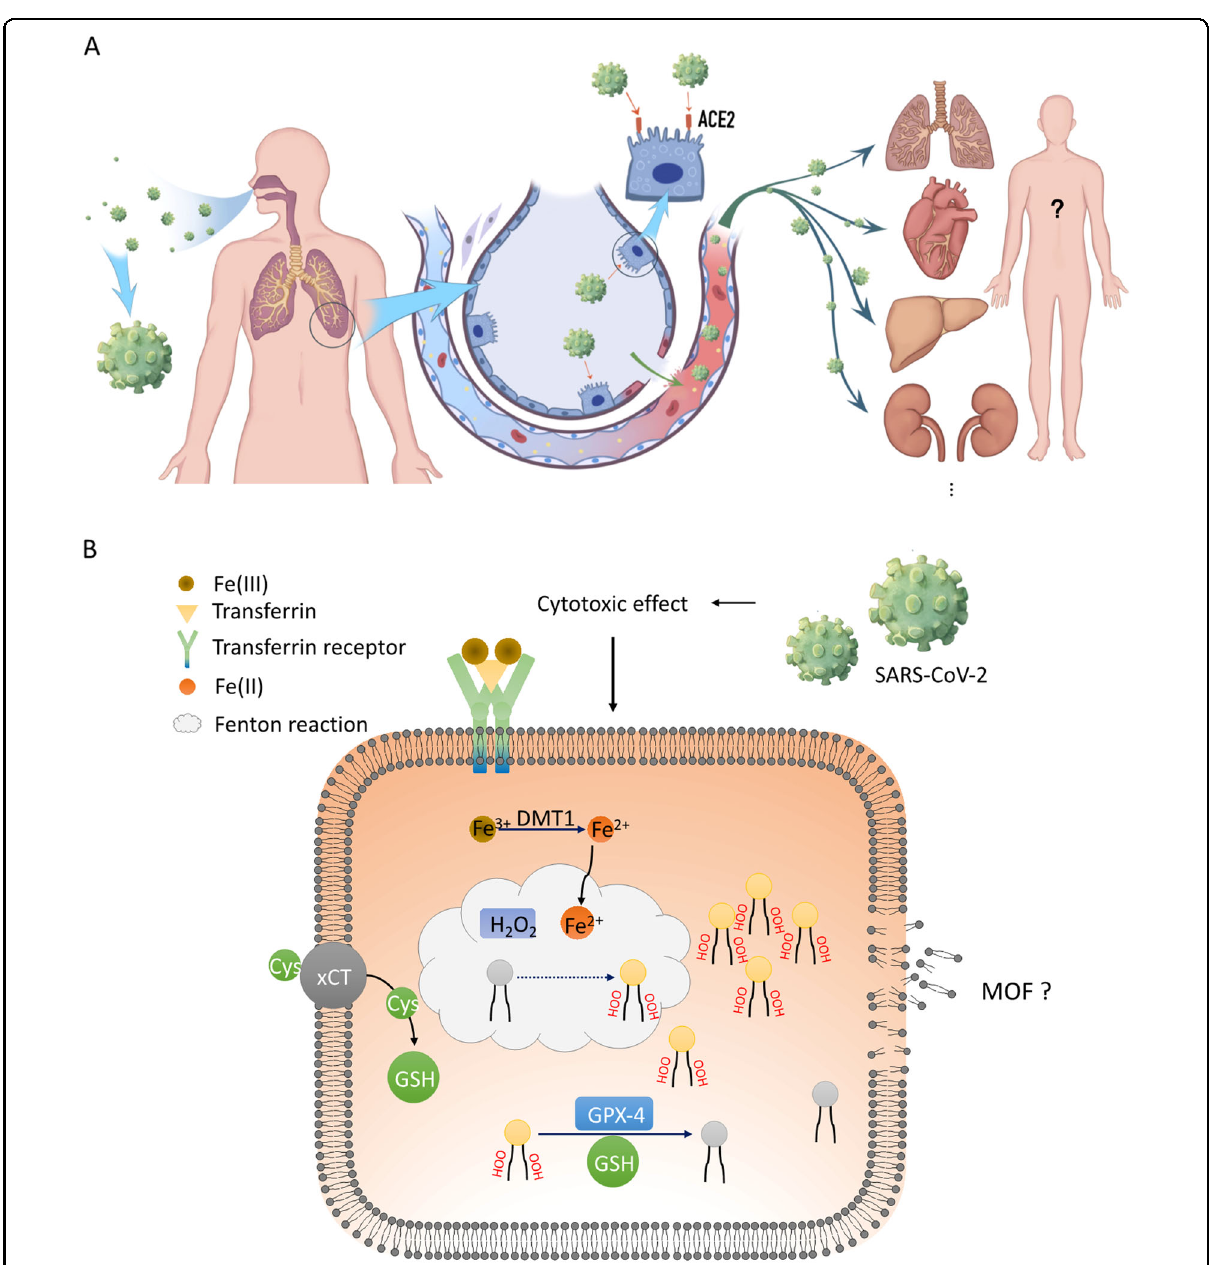
Fig. 1 SARS-CoV-2, Multiple Organ Failure and the Possible Triggering of Ferroptosis. A Schematic representation of SARS-CoV-2 causing multiple organ failure (MOF). SARS-CoV-2 recognizes the AEC2 receptor in the alveoli, especially the type II alveolar cells (AT2). This infection triggers the immune response and in fl ammation, causing damage to the blood-air barrier. In this case, SARS-CoV-2 therefore passes through the barrier, reaching to the capillaries and continues recognizing the ACE2 located in the different organs within the blood circulation. As a result, organs expressed with ACE2 may get infected and damaged by the activated immune system, thereby causing the MOF. B A hypothesis of how SARS-CoV-2 may trigger ferroptosis. After incubation period, the invading SARS-CoV-2 causes cytotoxic effect to multiple organs. Due to the infection, a plethora of transferrins carrying with Fe 3 + are recognized by transferrin receptors thereby entering into the cell. Then, divalent metal transporter 1 (DMT1) transformed Fe 3 + to Fe 2 + , accompanied with iron accumulation in the cell. Hydrogen peroxide (H 2 O 2 ), Fe 2 + , and lipid together cause Fenton reaction, producing massive lipid reactive oxygen species (ROS). This can be eliminated by glutathione (GSH) with the help of Glutathione peroxidase 4 (GPX4). However, owing to the iron overload, extensive Fention reaction would generate a large number of lipid ROS, causing cell membrane